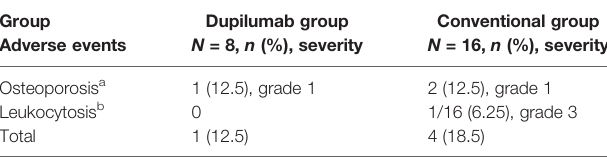
TABLE 3 | Details of adverse events in both